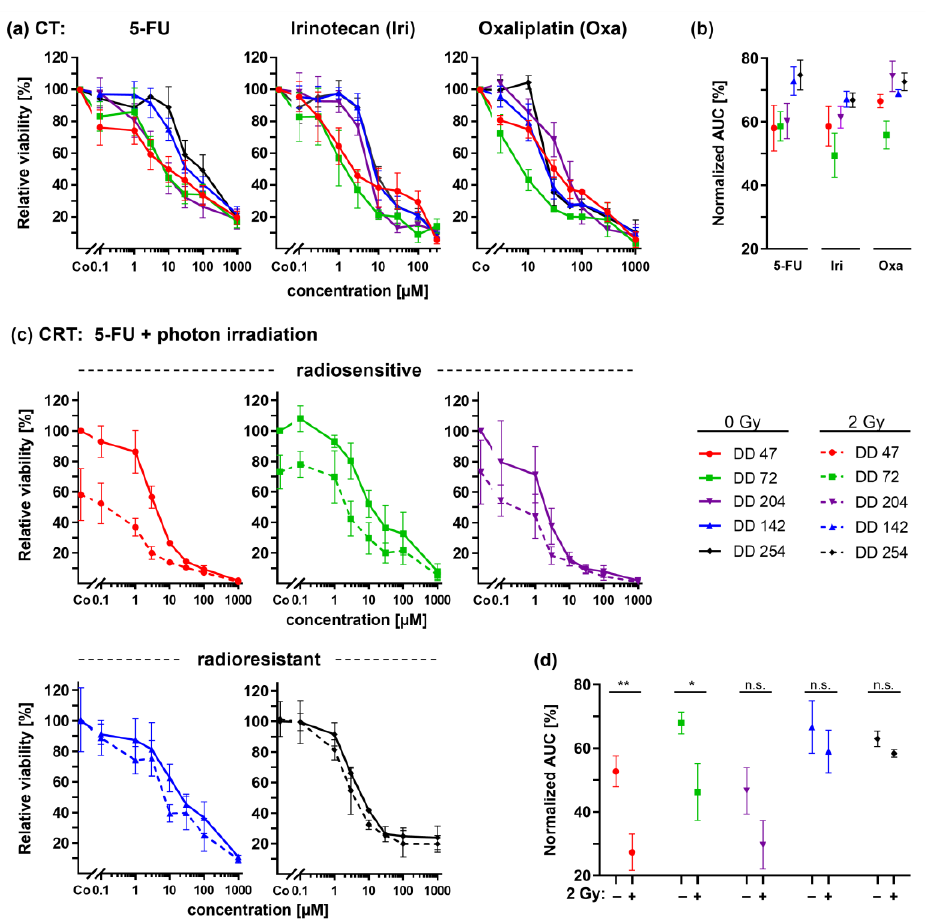
Figure 4. Chemotherapy (CT) and combined chemoradiotherapy (CRTx) of CRC PDOs. ( a ) Dose response curves upon treatment with 5-FU, irinotecan, and oxaliplatin alone and ( b ) resulting normalized AUCs. ( c ) Combined CRTx using 2 Gy photon irradiation with 5-FU and ( d ) resulting normalized AUCs ( p DD47 = 0.0088, p DD72 = 0.0328). *: p ≤ 0.05, **: p ≤ 0.01, n.s.: not significant.